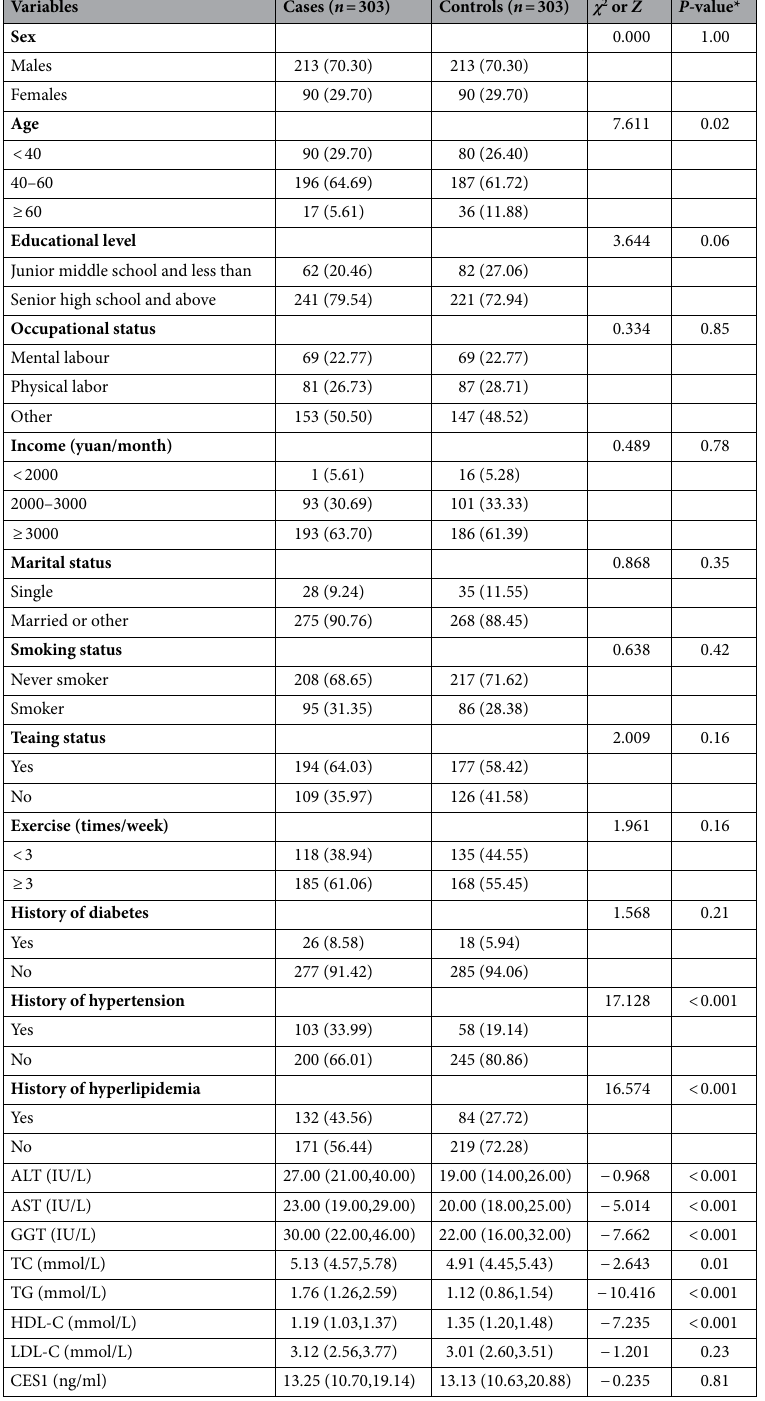
Table 1. General characteristics and clinical data of cases and controls, n (%) or medians (IQRs). ALT, alanine aminotransferase; AST, aspartate aminotransferase; GGT, gamma-glutamyltransferase; TC, total cholesterol; TG, triglycerides; HDL-C, high-density lipoprotein cholesterol; LDL-C, low-density lipoprotein cholesterol; CES1, carboxylesterase 1. * P -values were calculated by using the Chi-square test for categorical variables and Mann–Whitney U test for continues